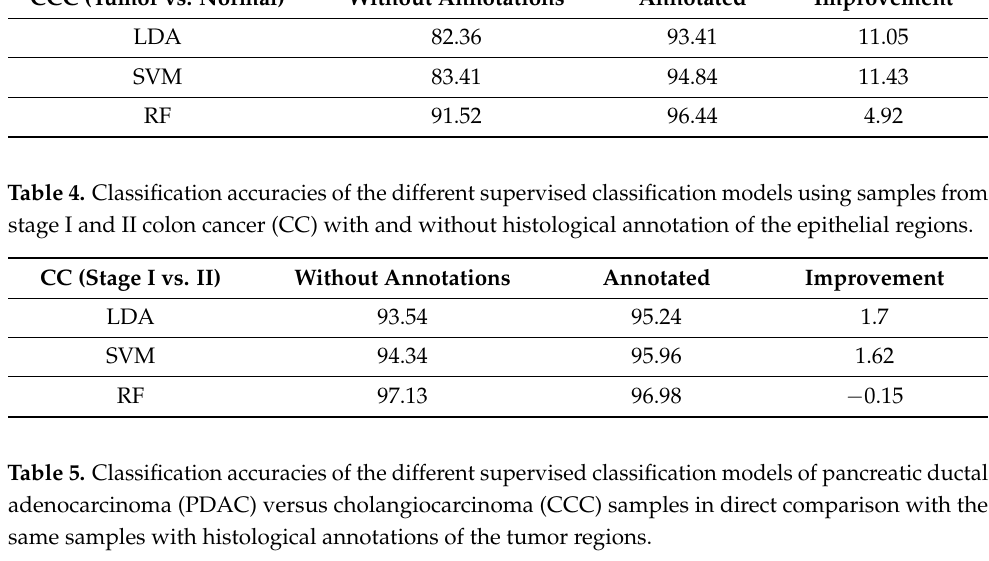
Table 3. Classification accuracies of the different supervised classification models using cholangiocar- cinoma (CCC) samples with and without histological annotations. CCC (Tumor vs. Normal)